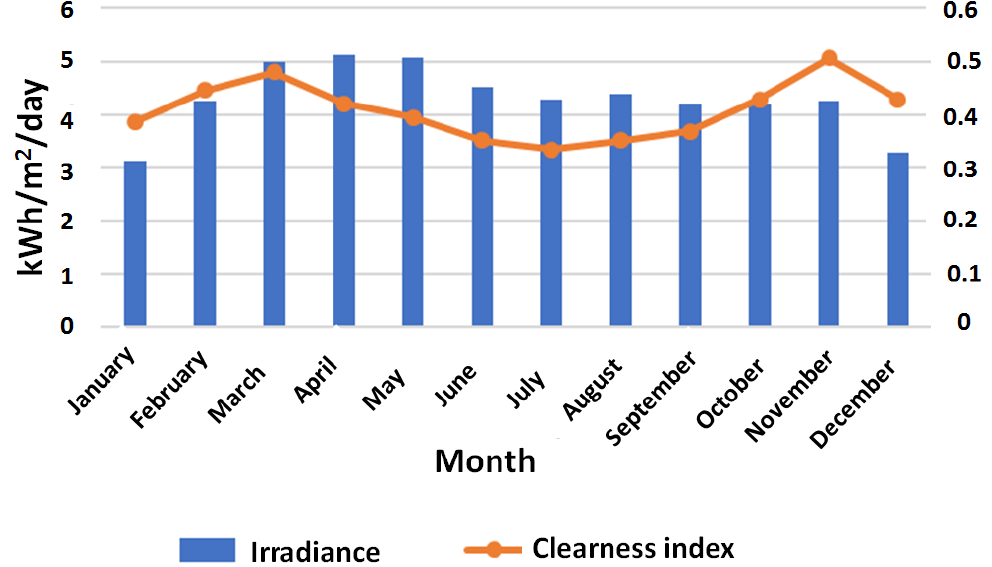
Figure 4. The average solar radiation and clearness index for a year.